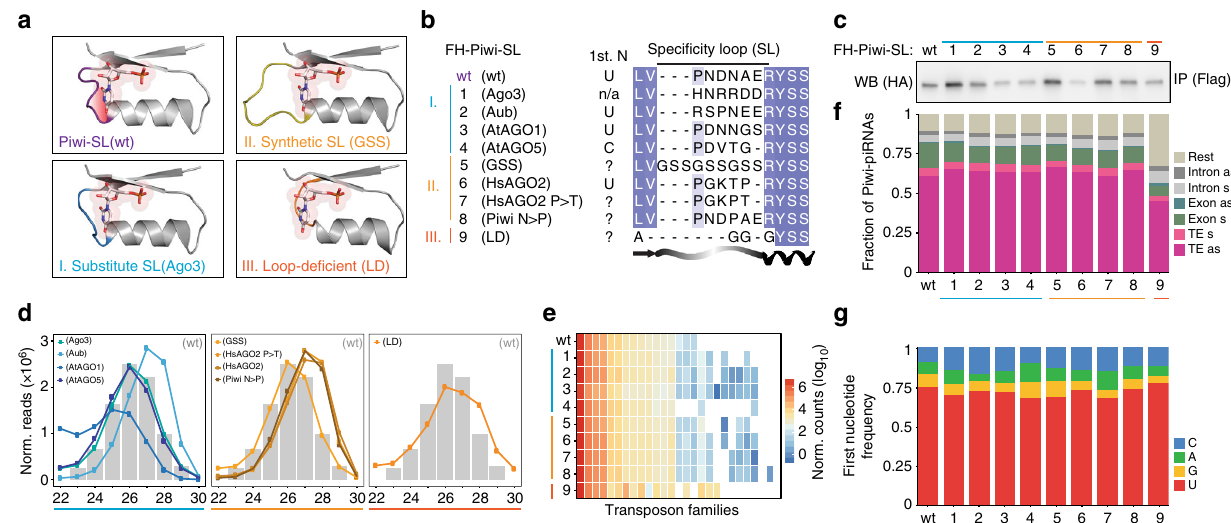
Fig. 1 The Speci fi city Loop (SL) contributes to, but does not solely determine the 1U bias of Piwi-piRNAs in ovarian somatic sheath cells (OSC). a Structural model of Piwi ’ s SL and of SL mutants in complex with monophosphorylated Uridine (U) based on the crystal structure of SIWI (PDB 5GUH). The SL is highlighted in purple for wild type (wt), blue for the substitute SL from Dm Ago3, yellow for the synthetic 3× (GSS) loop, and orange for the GGG linker in the loop de fi cient (LD) mutant. The recognition interface between the SL and the Uracil nucleobase is indicated in red for wt. b Flag-HA (FH) tagged Piwi constructs harboring wild type (wt) or mutant speci fi city loops (SL) (FH-Piwi-SL). The fi rst nucleotide preference of small RNAs that are physiologically associated with the original Argonaute protein is indicated (1st N). c FH-Piwi-SL proteins were expressed in OSC, immunoprecipitated (IP) using anti-FLAG antibody, and detected by western blotting (WB) by anti-HA antibody. d Nucleotide (22-30nt) length distribution of FH-Piwi-SL-piRNAs that associate with wt (gray) and the three categories of SL mutants. e Annotation of FH-Piwi-SL-piRNAs by their antisense targeting-potential for different transposon families. f Genomic origin of FH-Piwi-SL-piRNAs with respect to annotation categories in sense (s) and antisense (as) orientation. g Nucleotide frequencies at the fi rst position of FH-Piwi-SL-piRNAs. [ M ≤ 100: Unique mapping reads and primary alignments of multimapping reads are considered for the analyses represented in d – g ; read length was restricted to 24 – 29nt for analyses presented in e – g ]. (See also Supplementary Fig. 1 and Supplementary Data 3.)